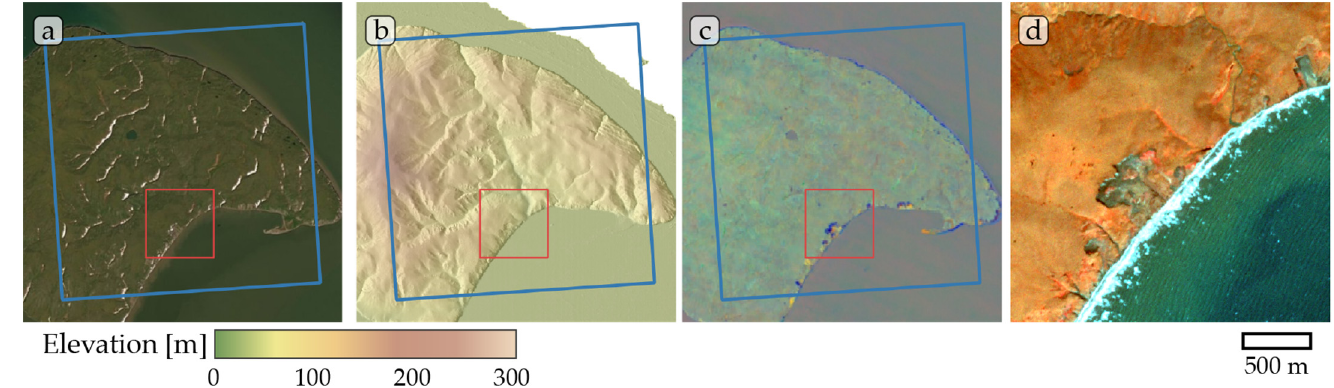
Figure A3. Study site Herschel Island 02. ( a ) ESRI satellite layer, ( b ) ArcticDEM superimposed with hillshade, ( c ) Tasseled Cap trend visualization, ( d ) PlanetScope satellite image (NIR-R-G) acquired on 02 September 2019. Blue box, 10 × 10 km study site. Red box detailed view of ( d ).